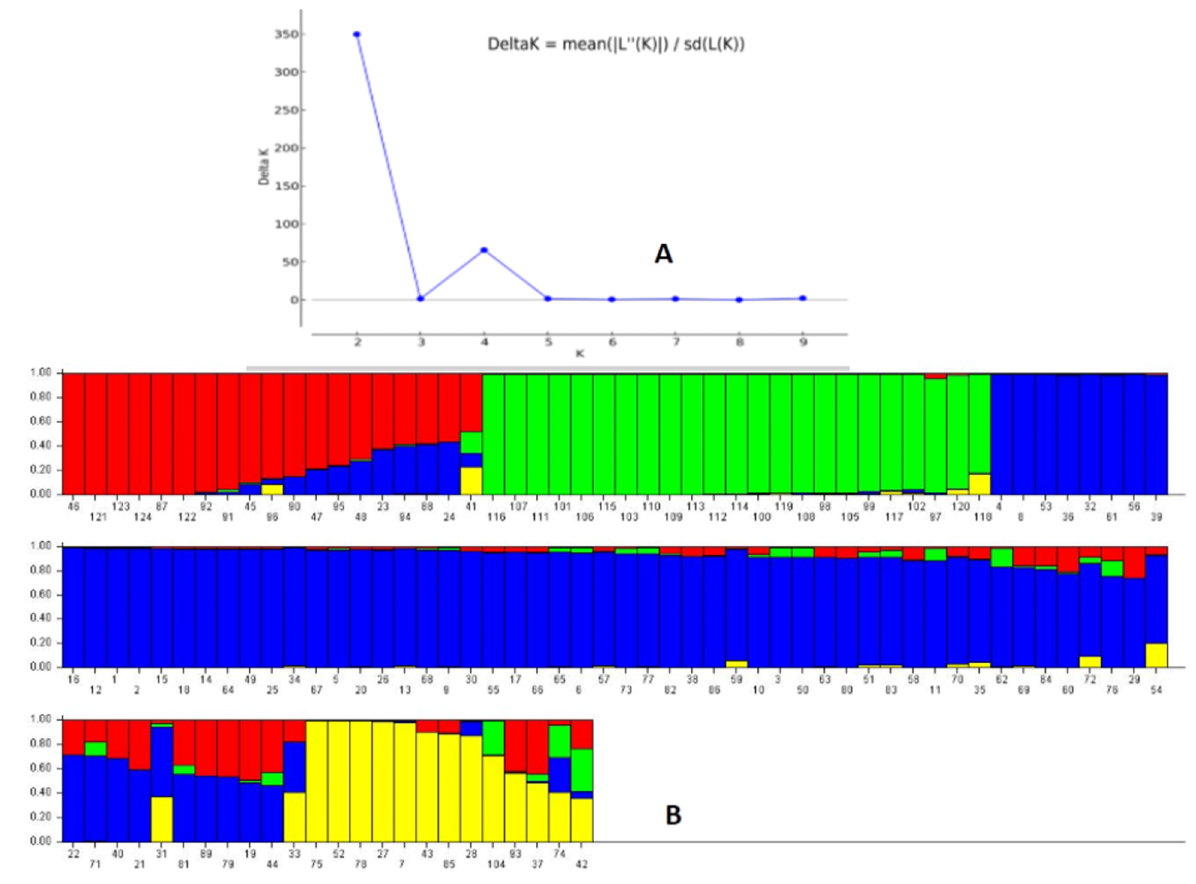
Figure 4. ( A ) Plot of ∆ K value and change in the log probability of data between successive K values; ( B ) population genetic structure obtained for the 124 germplasm lines in the panel population based on membership probability at K = 4. The germplasm lines showing ≥ 80% membership values were assigned as members of the subgroup, while others were admixture type. The serial numbers of the genotypes present in the diagram are as per the germplasm serial numbers in Table1.